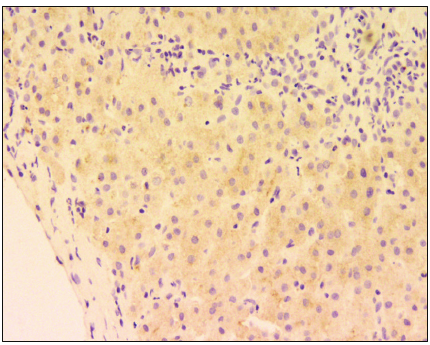
Figure 3: Liver biopsy of Case B, at 20x magnification showing staining for BSEP protein.